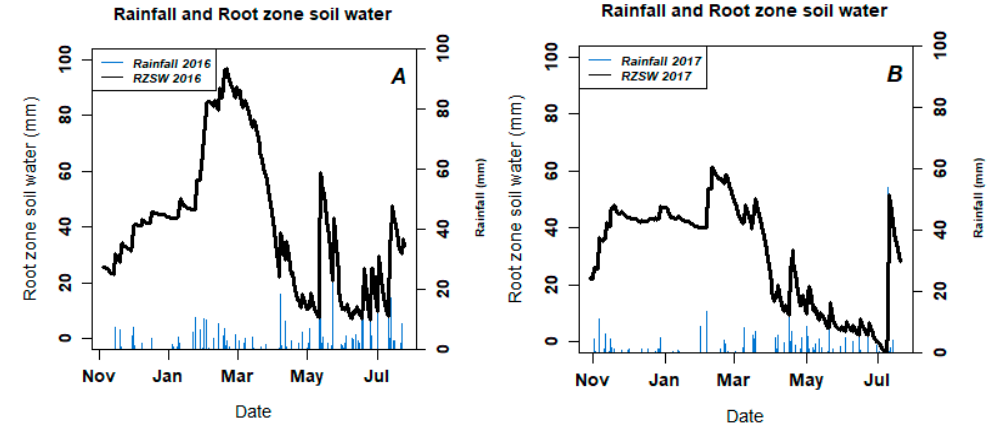
Figure 9. Precipitation (blue bars) and simulated water content in the root zone (black line) in 2016 ( A ) and in 2017 ( B ) for one of the high fertilizer plots (180 kg N /ha).